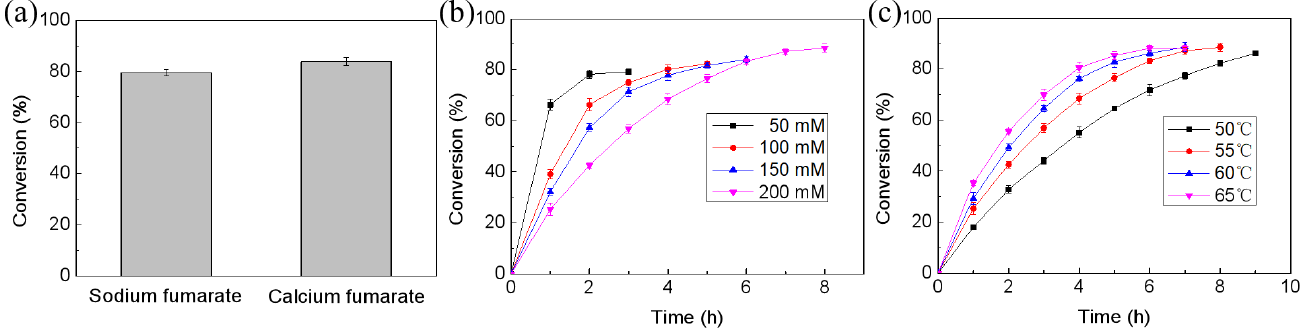
Figure 5. Transformation of fumarate to L -malate by immobilized fumarase. ( a ) The effects of substrate types on fumarate conversion; ( b ) The effects of substrate concentration on calcium fumarate conversion; ( c ) The effects of temperature on calcium fumarate conversion.